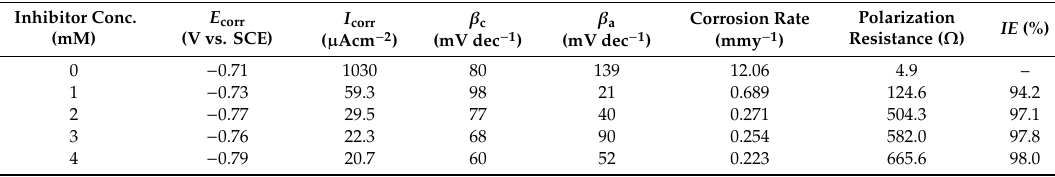
Figure 4. Potentiodynamic polarization curves for the corrosion of AA 6061 alloy in 1 M HCl solution without and with various inhibitor concentrations at 303 K. Table 2. Polarization parameters for the corrosion of AA 6061 alloy in 1 M HCl containing various concentrations of inhibitor at 303 K.